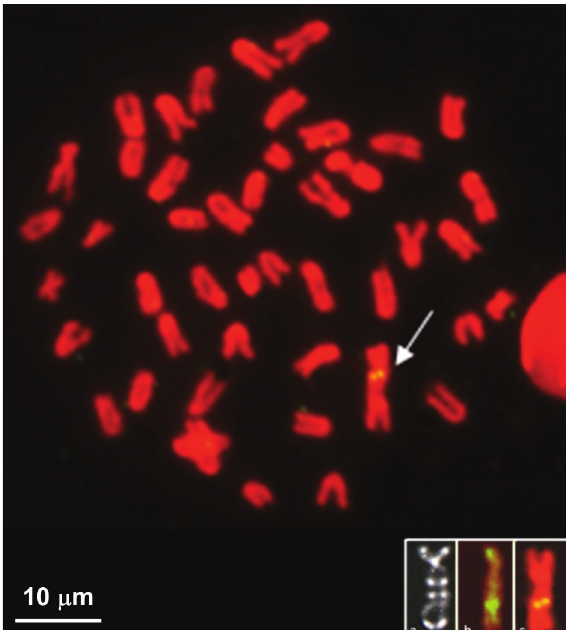
Figure 5. In situ hybridization of the C3 probe (CIN1/L4) to the Ch. hamatus male karyotype: the probe clearly maps interstitially on the q arm of the Y chromosome. Insert: a C-banded and chromomycin- stained Y chromosome of Ch. hamatus and b FISH performed using the Tc1-like DNA transposon as probe (modified from fig. 5 of Capriglione et al. 2002) compared to c C3 hybridized Y